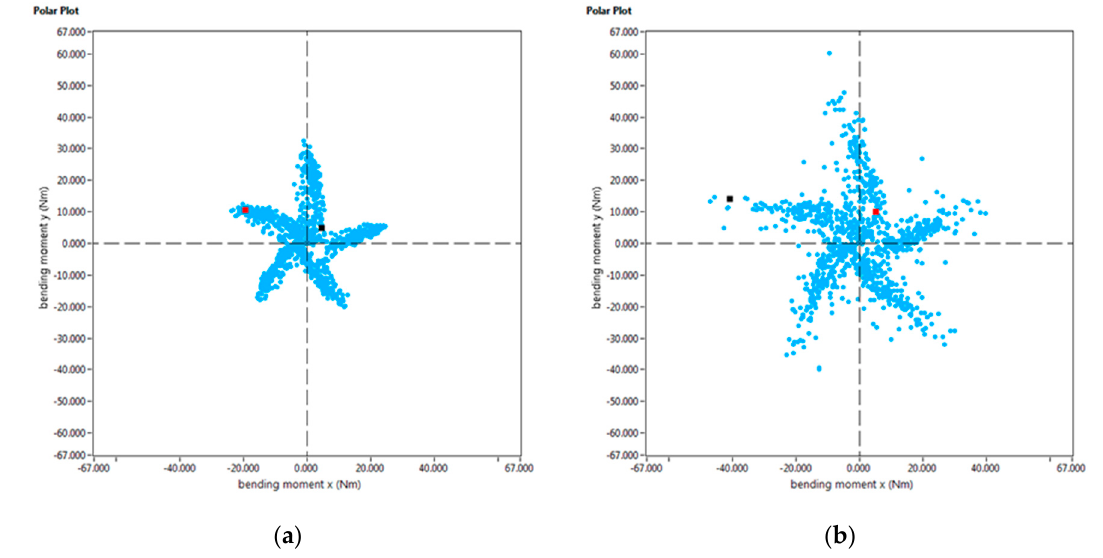
Figure 16. Signals acquired during slot milling across the wall.